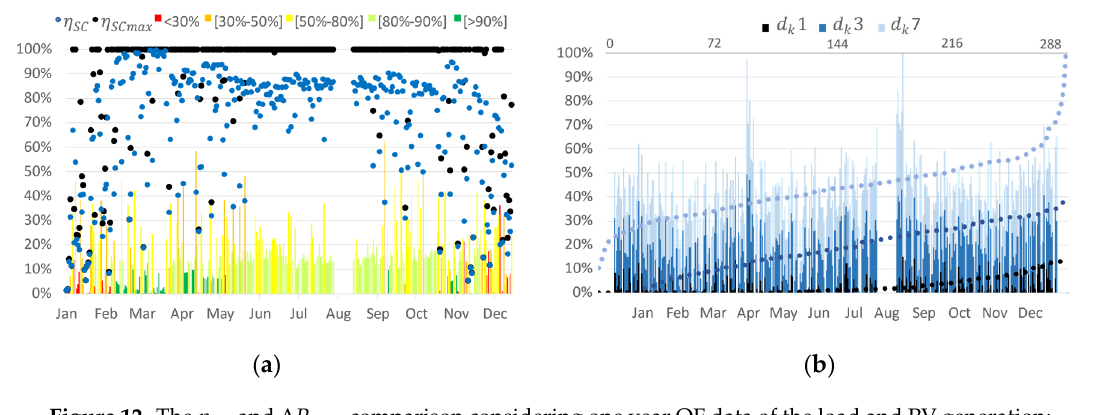
Figure 12. The η SC and ∆ P PCC comparison considering one year OF data of the load and PV generation: ( a ) η SC values referred to d k = 3; and ( b ) percentage peak value (columns) as a function of seasonality (bottom x axis) and in ascending order (dot lines) as a function of working days (top x axis).